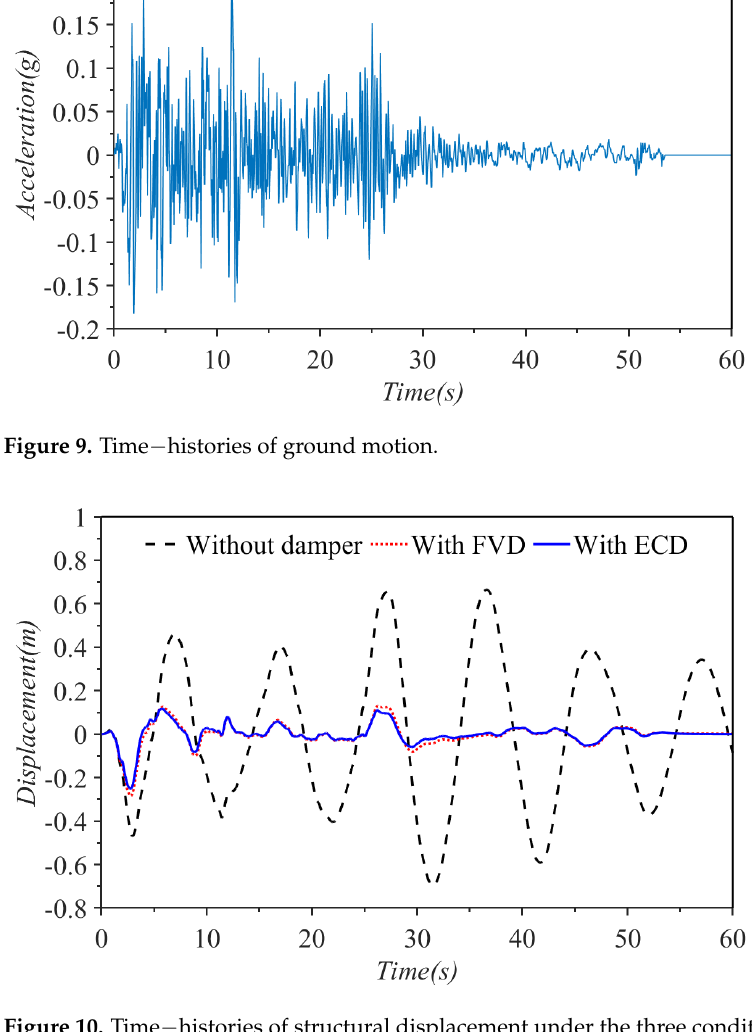
Figure 10. Time − histories of structural displacement under the three conditions.